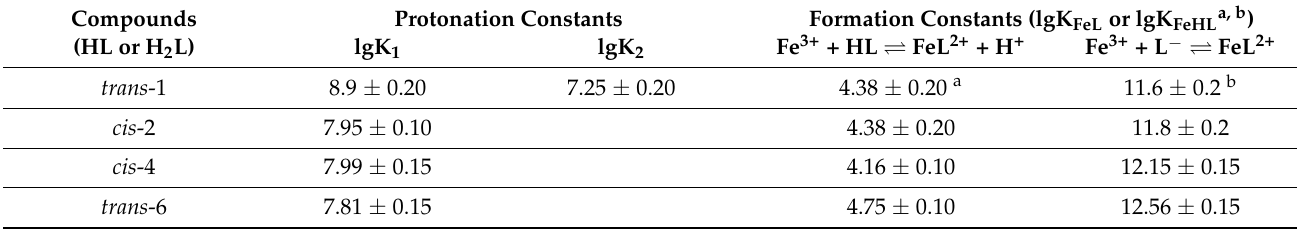
Table 2. Protonation constants for the deprotonated compounds (L − or L 2 − ) and the constants for the formation of FeL 2+ or FeHL 2+ complexes.